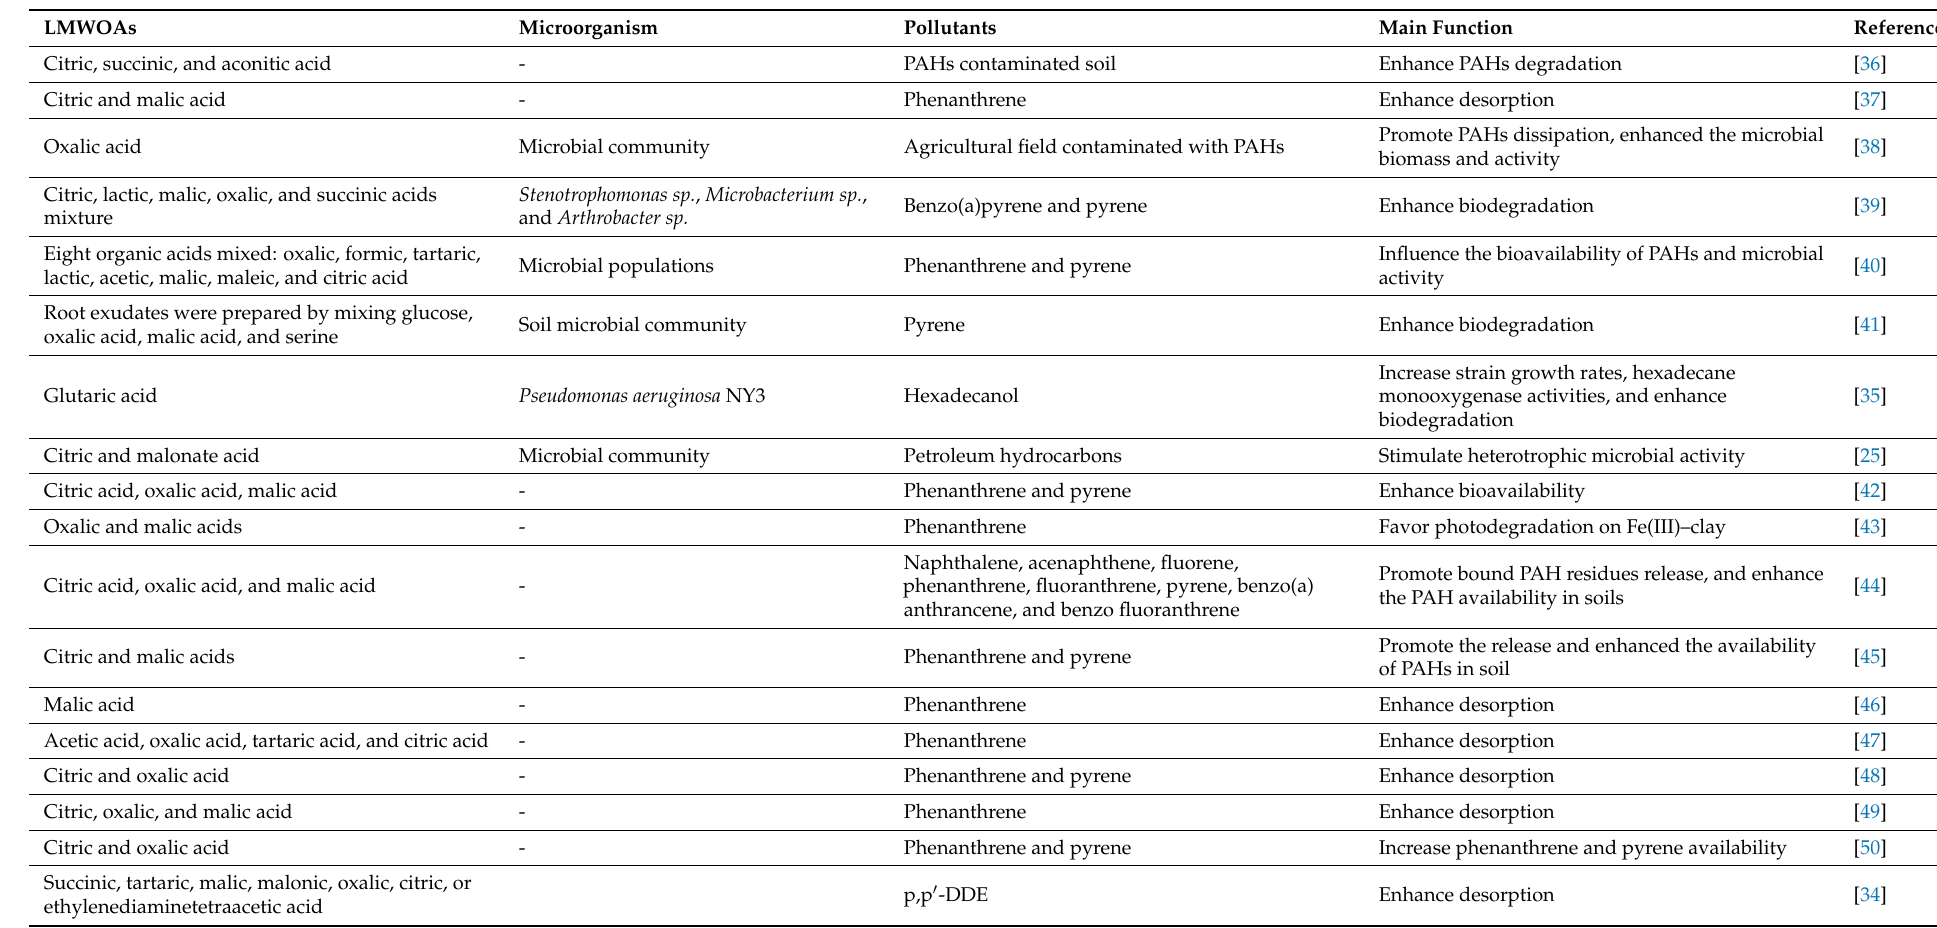
Table 1. The predominant low molecular weight organic acids (LMWOAs) applied to enhance microbial degradation of